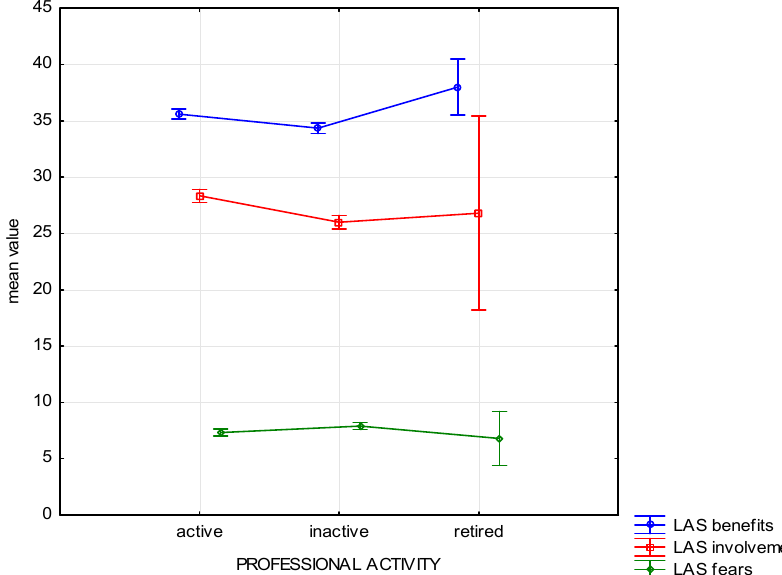
Figure 4. Attitude to the forest—mean chart for groups based on the place of residence.